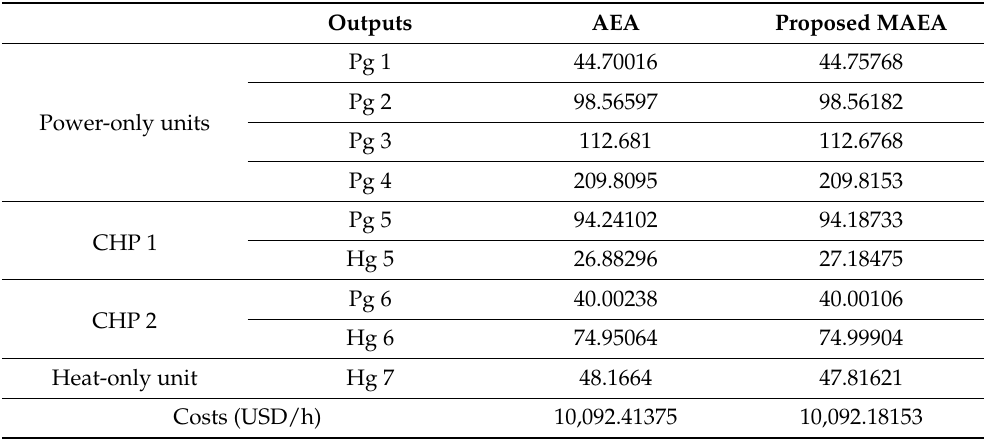
Table 1. Optimal operational settings and related costs of the proposed MAEA and the basic AEA of Case